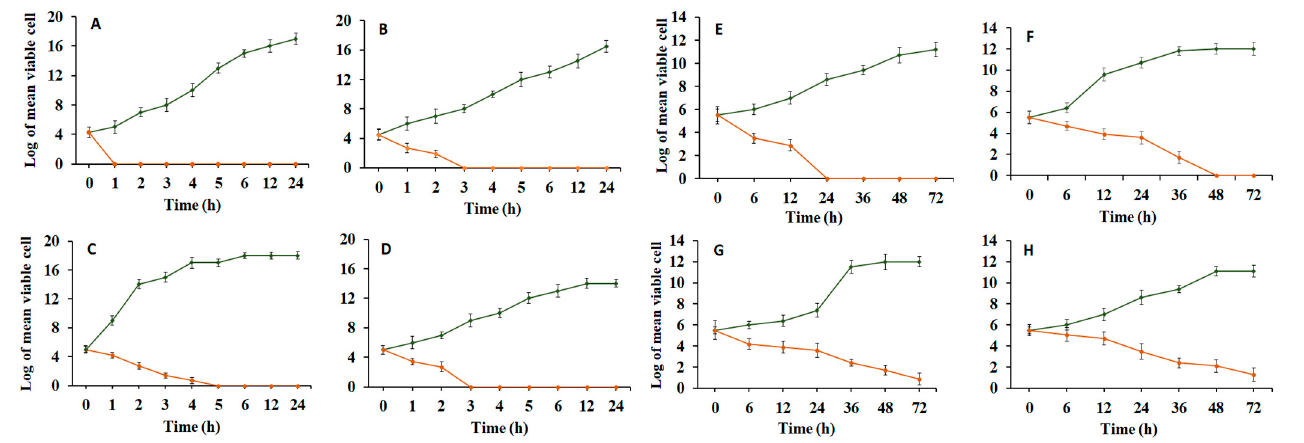
Figure 3. Mangiferin’s time–kill curve against different bacterial and fungal pathogens ( A ) S. aureus , ( B ) E. coli , ( C ) S. fl exneri , ( D ) P. aeruginosa , ( E ) C. albicans , ( F ) C. glabrata , ( G ) C. parapsilosis ( H ) C. tropicalis , and untreated pathogen cells as growth controls. An overnight culture of selected strains were treated with the respective MICs of mangiferin and then incubated at 37 °C. Samples were gathered at the scheduled intervals and plated. Before counting the colony-forming units (CFU), the plates were incubated for 48 h.